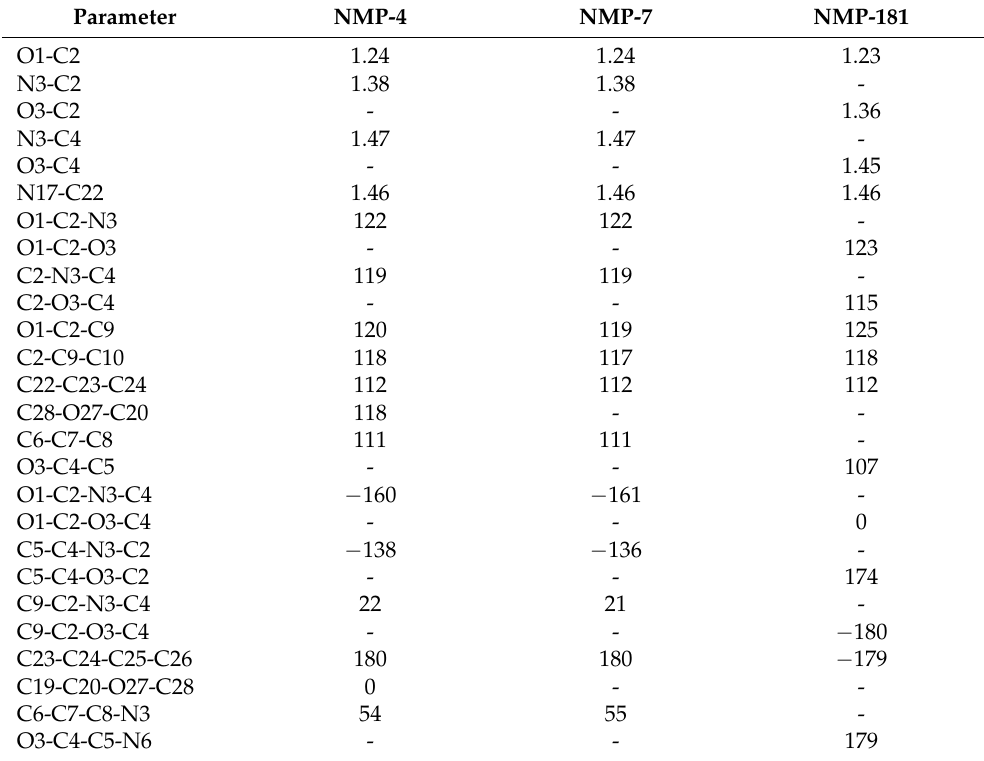
Table 1. Selected bond lengths (Å), valence angles, and dihedral angles (degrees) for the NMP com- pounds at the BP86/cc-pVTZ level of theory in chloroform.